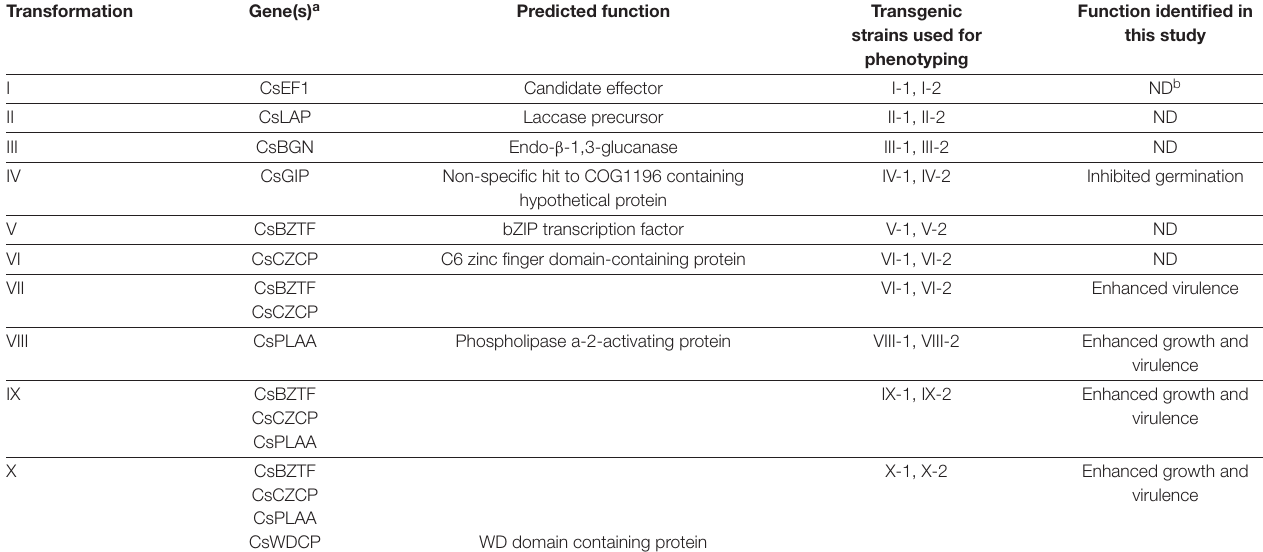
TABLE 1 | Genetic transformation and phenotyping in strain Coll-365. Transformation Gene(s) a Predicted function Transgenic